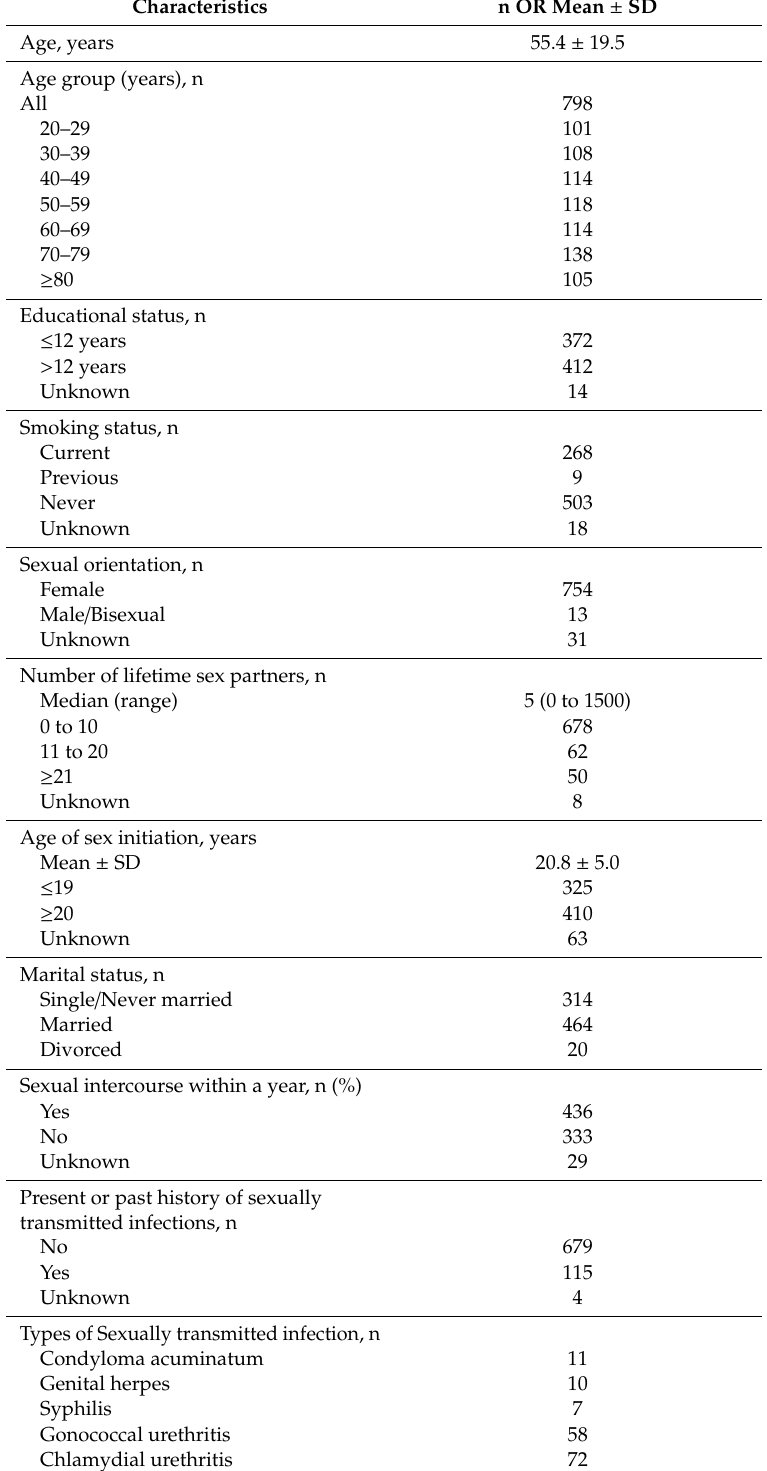
Table 1. Characteristics of study